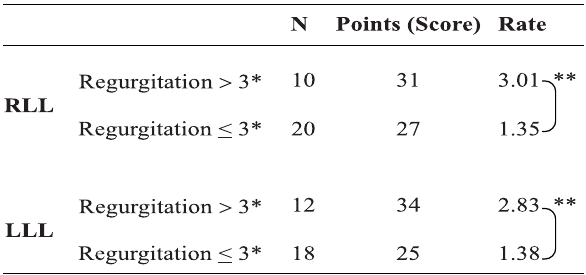
RLL and LLL: Right and Left Lower Limbs